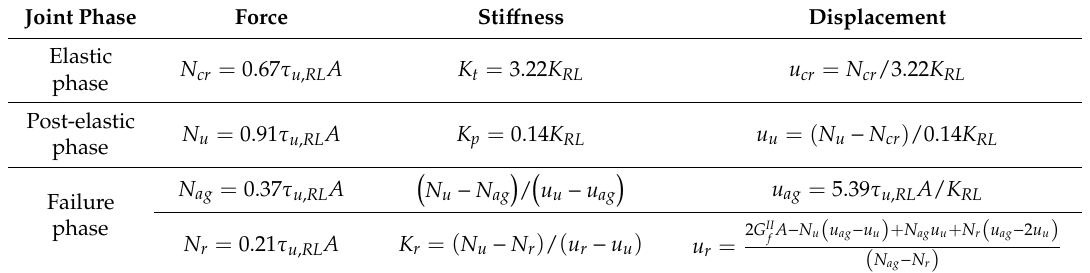
Table 6. Relationships describing the work of unreinforced joints between walls.